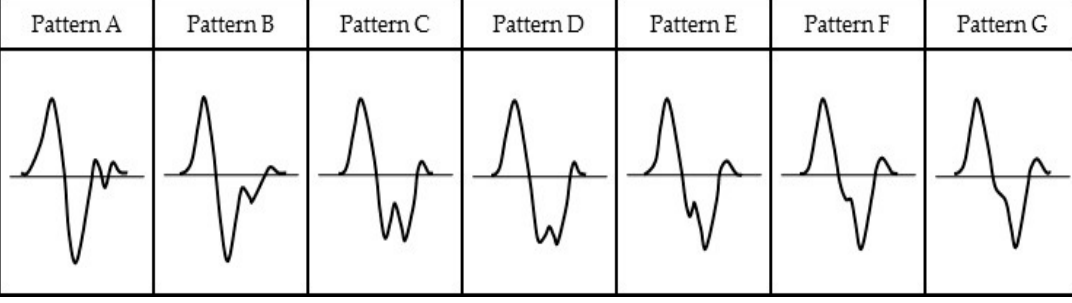
Figure 6. Seven patterns of the acceleration pulse wave.